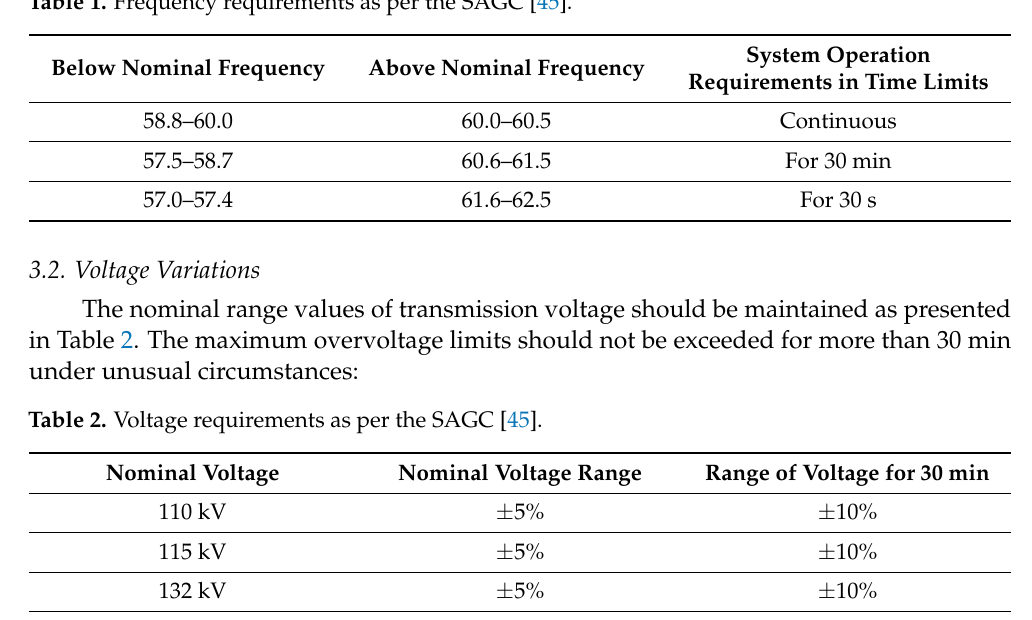
Table 1. Frequency requirements as per the SAGC [45].